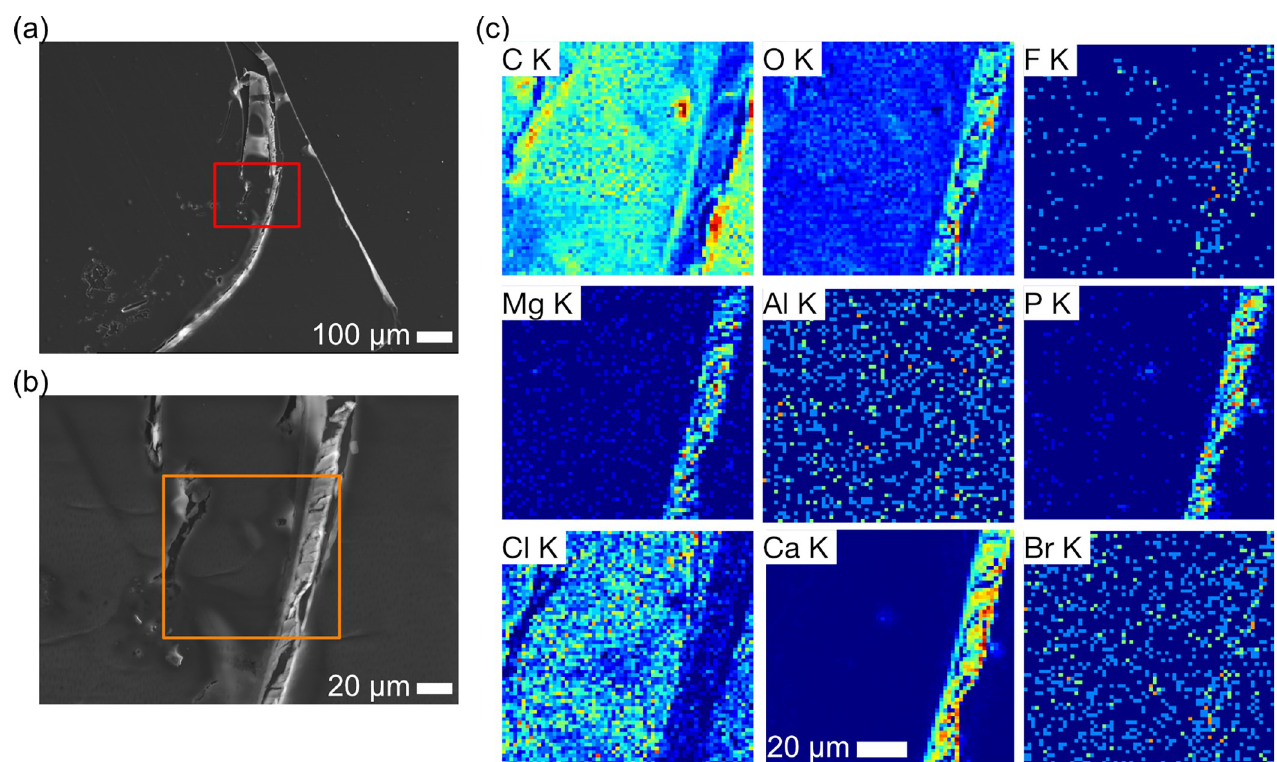
Fig 4. SEM images and elemental maps of a semi-thin section of the pereonite in Hirondellea gigas . a) Low-magnification SEM image. b) High- magnification SEM image of the red rectangle in (a). c) WDS elemental maps of the orange rectangle in (b).